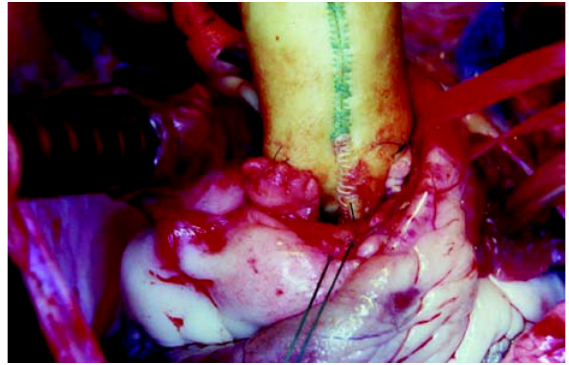
Fig.3 – Aspecto final do implante do tubo stentless.